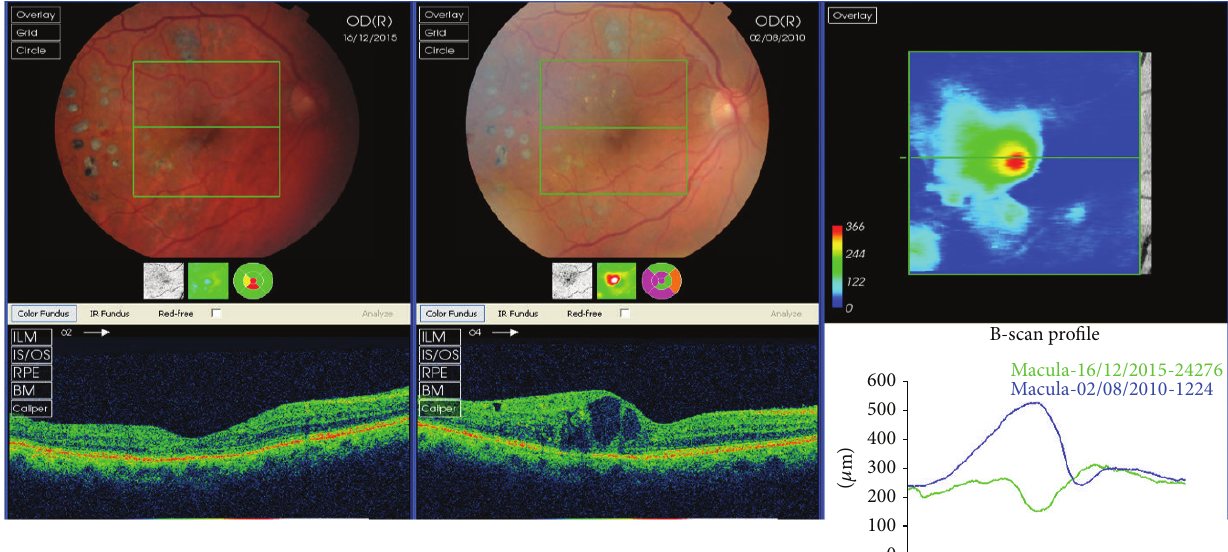
Figure 3: Evolution of a patient with diabetic macular edema, from 2012 to 2015. The patient did not respond to anti-VEGF but to steroids. Perhaps, the hyperreflective retinal spots, seen in the first tomography in the outer plexiform layer temporal to the fovea, can be a predictive sign of a positive response to